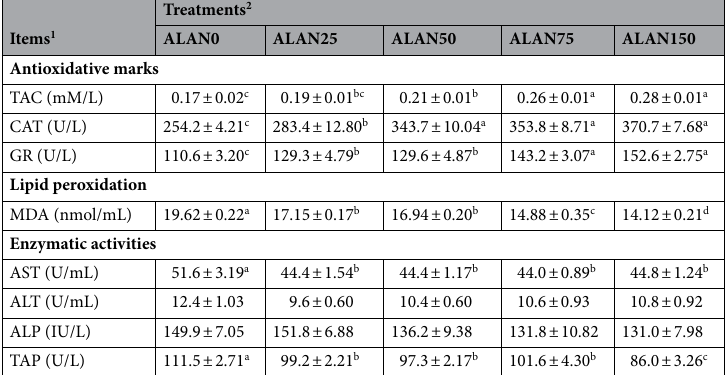
Table 5. Effect of supplementing Tris-extender with alpha-lipoic acid loaded liposomes (ALAN) on antioxidant, oxidative markers and enzymatic activities in extender of post-thawed buffalo bull semen (means ± SE). 1 TAC, Total antioxidant capacity; CAT, Catalase; GR, Glutathione reductase; MDA, Malondialdehyde; AST, Aspartate aminotransferase; ALT, Alanine aminotransferase; ALP, alkaline phosphatase; and TAP, Total Acid Phosphatase. 2 Tris extender supplemented with different levels of alpha- lipoic acid loaded liposomes (ALAN) containing 0 (ALAN0), 25 (ALAN25), 50 (ALAN50), 75 ALAN75 and 150 ALAN150 (0, 25, 50, 75 and 150 µg/mL), respectively. a–d means denoted within the same row with different superscripts are significantly different at P < 0.05.